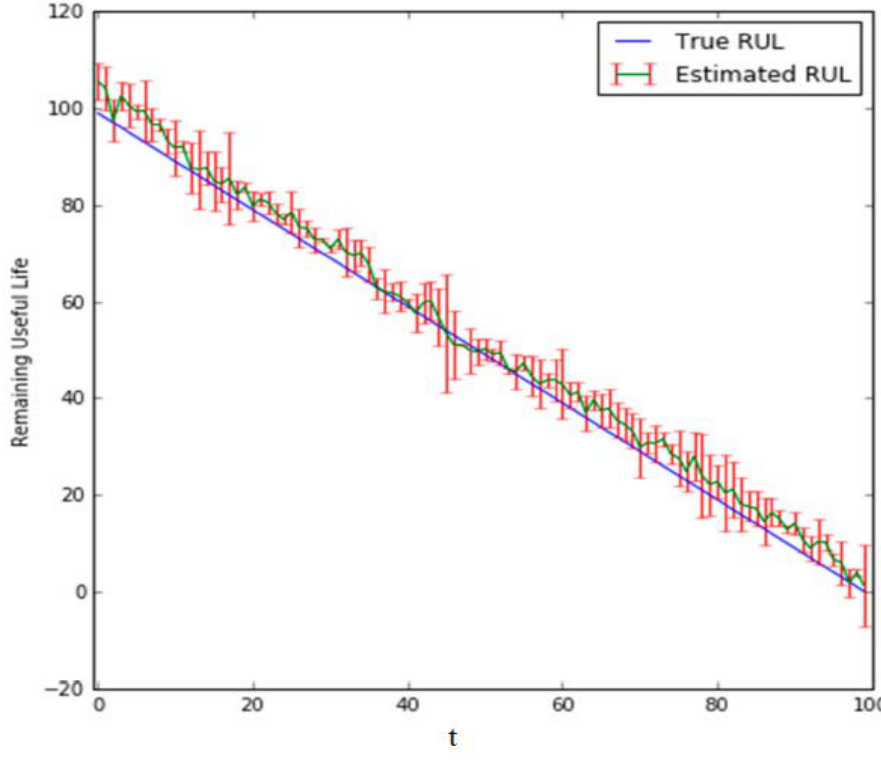
Figure 21. Degradation tracking for the RUL of roller bearings [65].